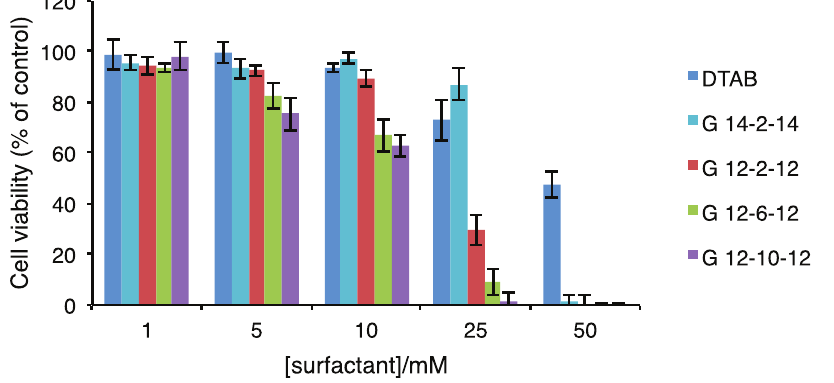
Figure 2. Recovery capability of NCTC 2544 cells 48 h after removing surfactants from the culture medium. Cell viability values are presented as mean 6 SD of a characteristic profile (3 repetitions) selected from 5 independent experiments.